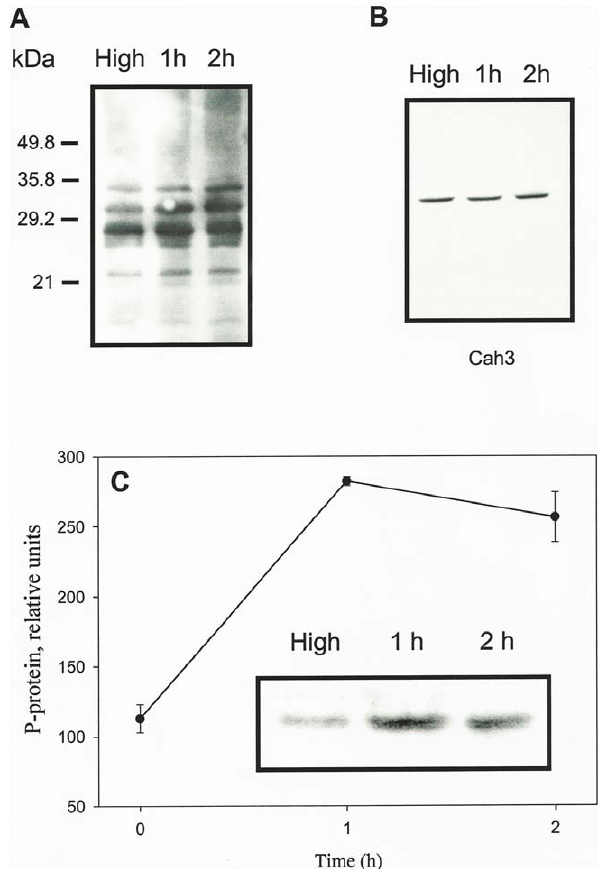
Figure 3. Phosphorylation of LHCIIP and PSII polypeptides during acclimation to low CO 2 conditions. ( A ) Immunoblot analysis of thylakoid membrane proteins isolated from high-CO 2 -grown cells (H), and cells acclimated to low CO 2 for 1 (1 h) and 2 h (2 h) probed with antibodies against phosphothreonine (Thr(P)). ( B ) Immu- noblot analysis of extrinsic thylakoid proteins isolated from thylakoids of high-CO 2 -grown cells (H), and cells acclimated to low CO 2 for 1 (1 h) and 2 h (2 h), probed with affinity-purified antibodies against Cah3. ( C ) Changes in the immunoresponse of Thr(P) antibody to a 30-kDa phosphoprotein during the acclimation to low CO 2 . The inset shows immunoblot analysis of extrinsic thylakoid proteins isolated from thylakoids of high-CO 2 -grown cells (H), and cells acclimated to low CO 2 for 1 (1 h) and 2 h (2 h), probed with Thr(P) antibodies. The lanes were loaded with 10 m g protein.